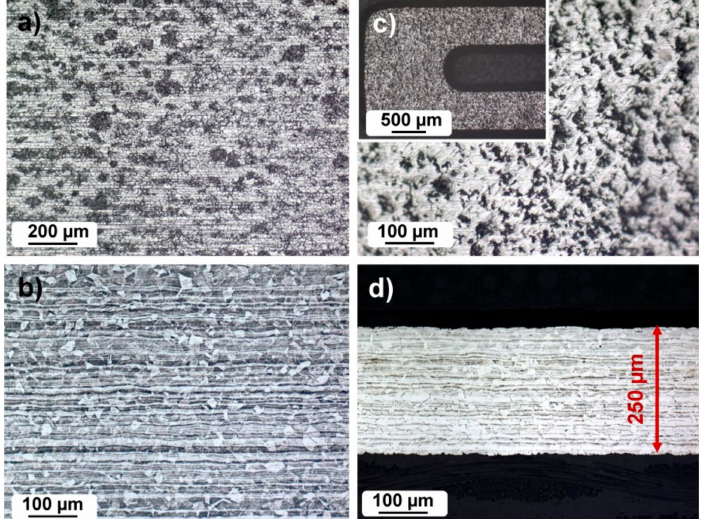
Figure 3. ( a ) The microstructural investigation of high strength steel sheet in top view, as-received; ( b ) the cross-section of the as-received sheet; ( c ) Etched surface, with an inset of the details of the sensor lead, and ( d ) the